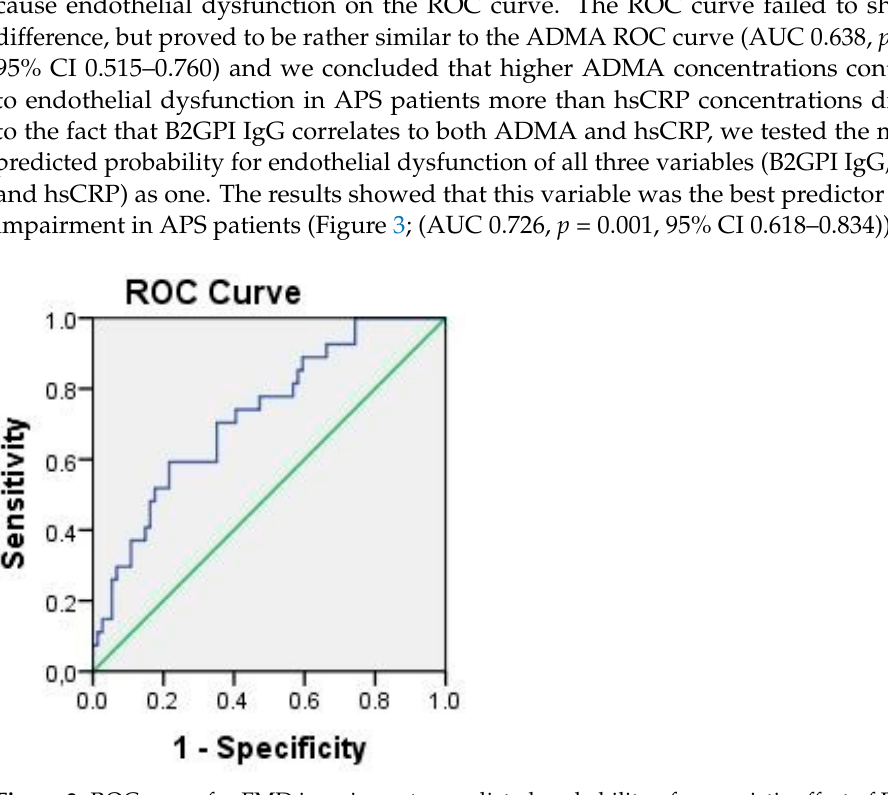
Figure 2. ROC analysis for hsCRP and FMD impairment.